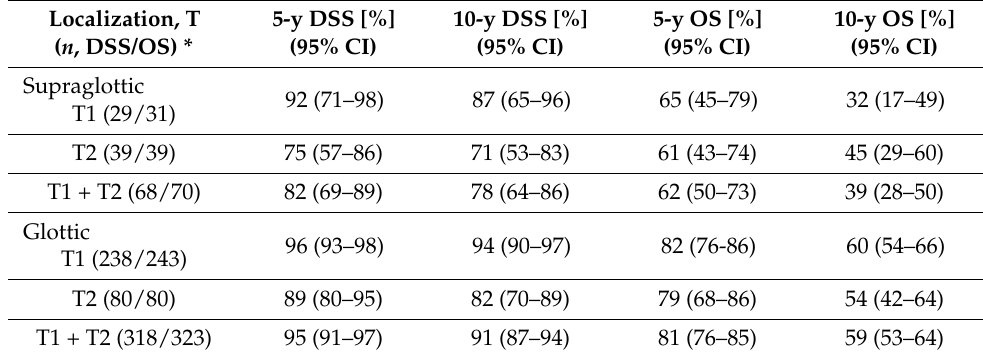
Table 2. 5-year and 10-year DSS and OS of early-stage supraglottic and glottic cancers after TLM.